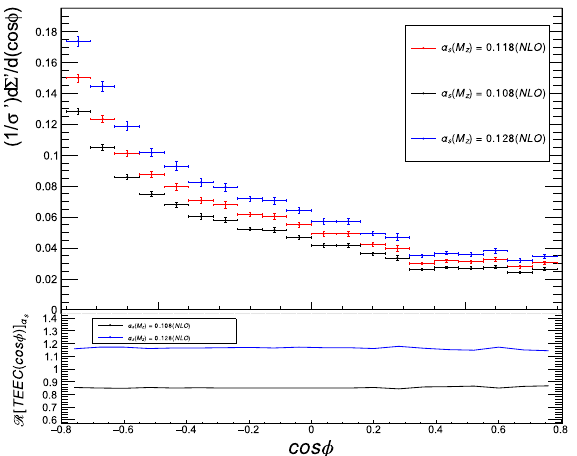
of MMHT14 in the low- Q 2 range at HERA setting the scales μ = μ = μ R [ TEEC ( cos φ) ] α F R 0 . Lower frames: The ratios s = 0 . 108 and R [ TEEC ( cos φ) ] α and R [ ATEEC ( cos φ) ] α and s = 0 . 128 s = 0 . 108 R [ ATEEC ( cos φ) ] α , defined in Eq. (18) s = 0 . 128